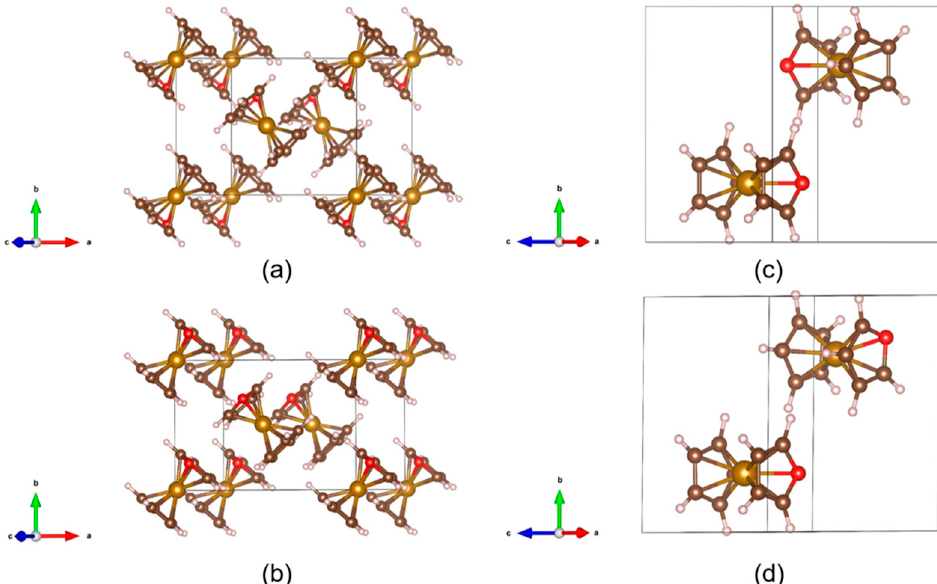
Figure 2. Optimized crystal structure of azaferrocene constructed using the ( a ) room temperature and ( b ) low temperature monoclinic ferrocenes as prototype structures; triclinic ferrocene with the two constituent azaferrocene molecules ( c ) antiparallel (AFE) and ( d ) almost parallel (FE) to each other. Azaferrocene constructed using the two monoclinic ferrocene structures has a polar ground state. The two structures are denoted as M1 and M2, respectively. Key: C: dark brown; Fe: brown; H: pink; N: red.